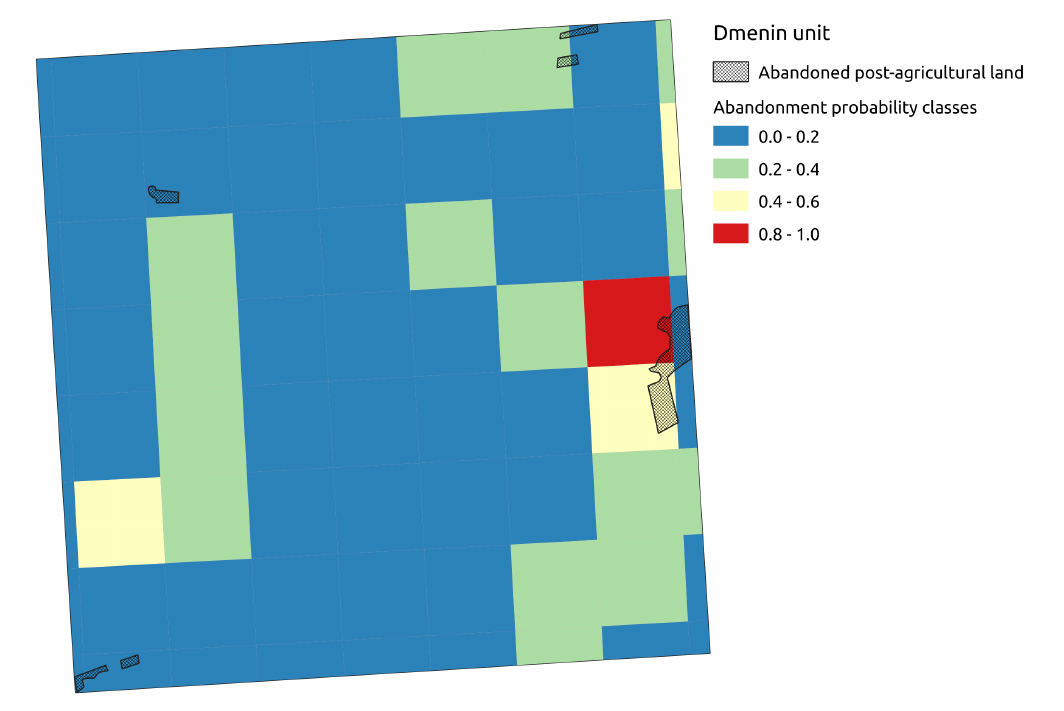
Figure 11. Abandoned postagricultural land in the “Dmenin” unit, superimposed over abandonment probability classes (coldspot